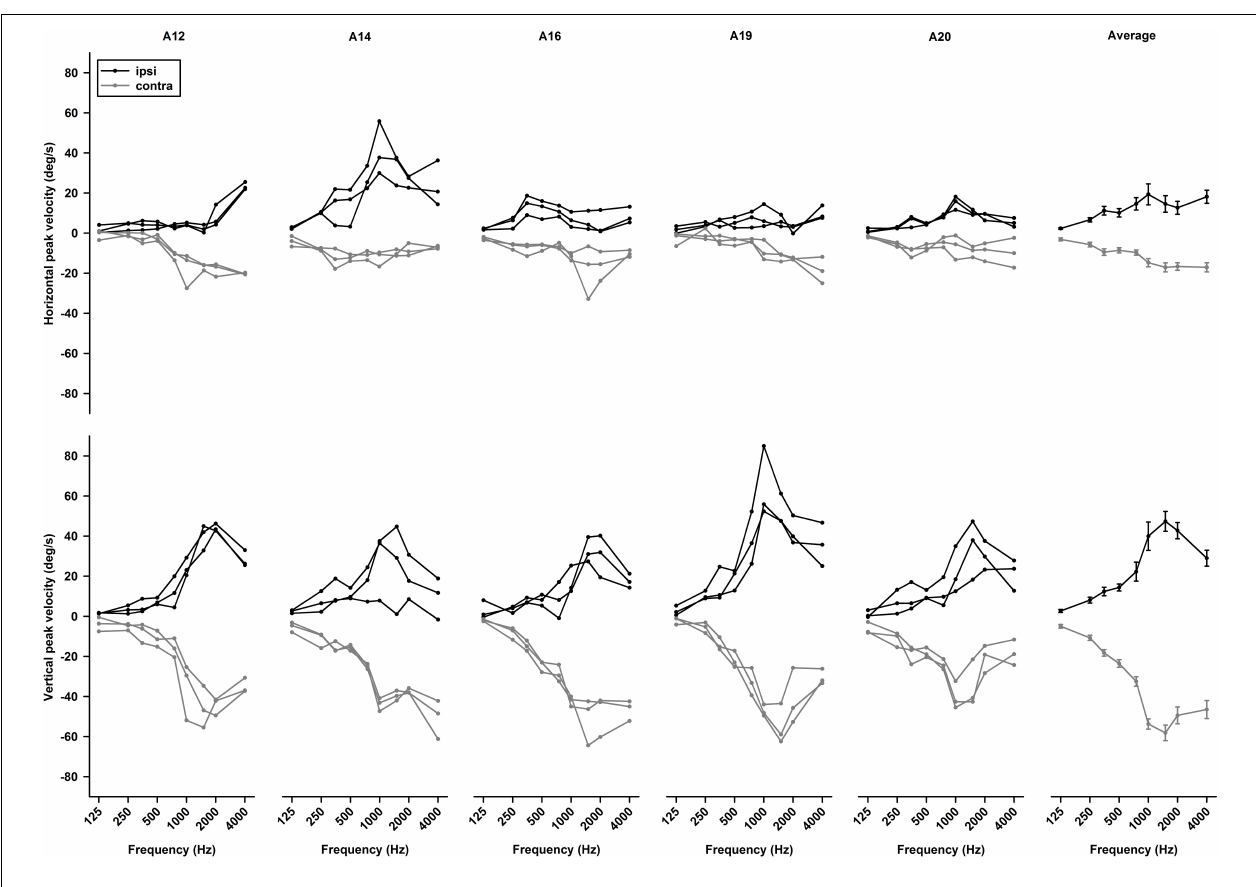
FIGURE 10 | Repeatability of tone bursts-evoked eye movements. Upper panels are horizontal eye movement tuning curves of five rats obtained in three consecutive days. Lower panels are vertical eye movement tuning curves of rats obtained in three consecutive days. The last right panels are averaged tuning curves from the five